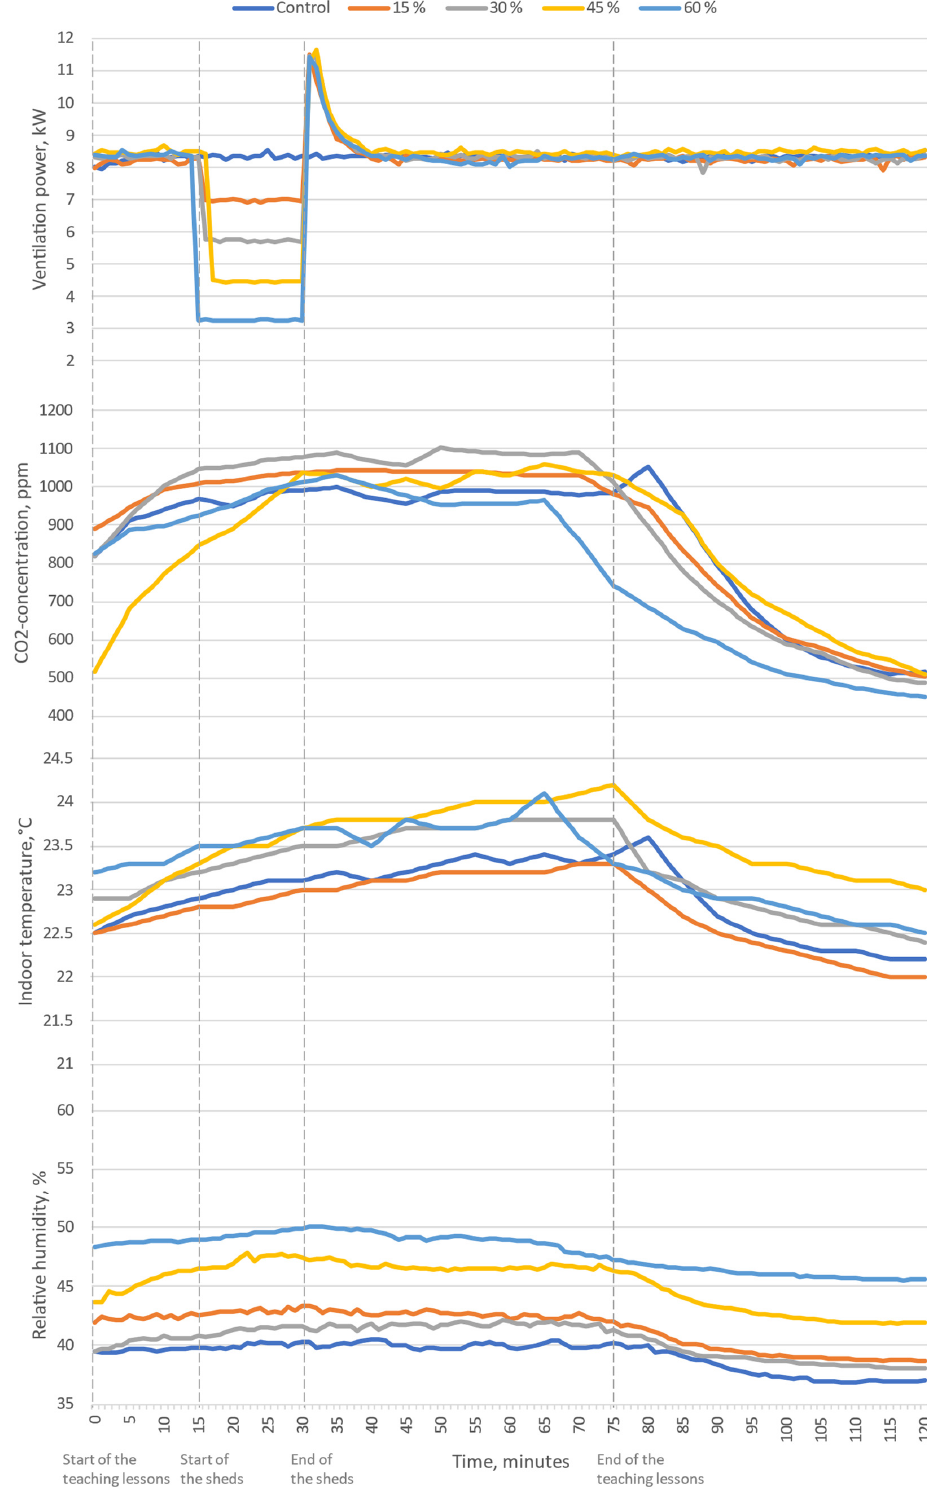
Figure 3. The ventilation power and the indoor CO 2 -concentration, the temperature and the relative humidity data obtained from the 15 min tests.